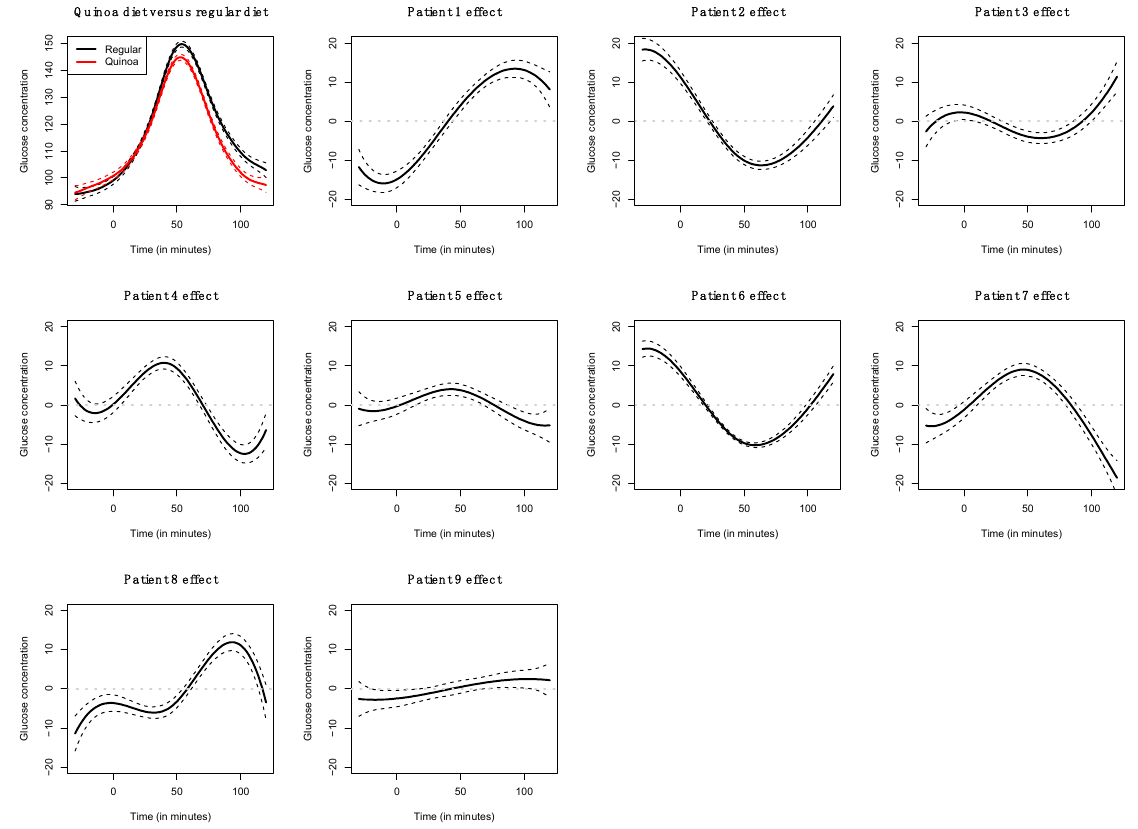
Figure 3. Coefficient estimates for the functional linear model with diet factor and patient effect.